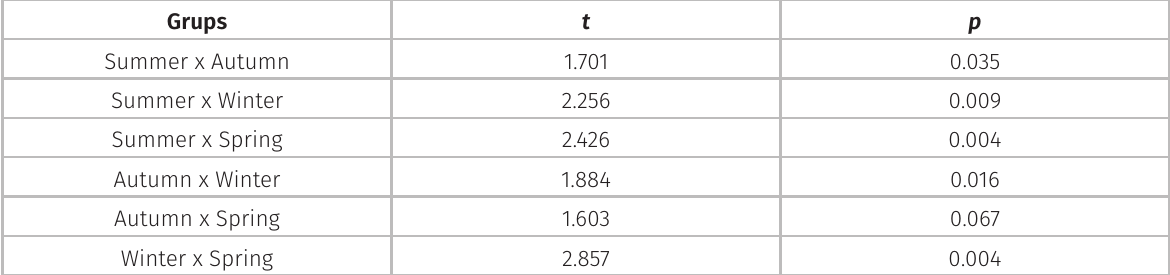
Table III. The pairwise test among the seasons of L. anus diet, collected in the Chasqueiro reservoir, southern